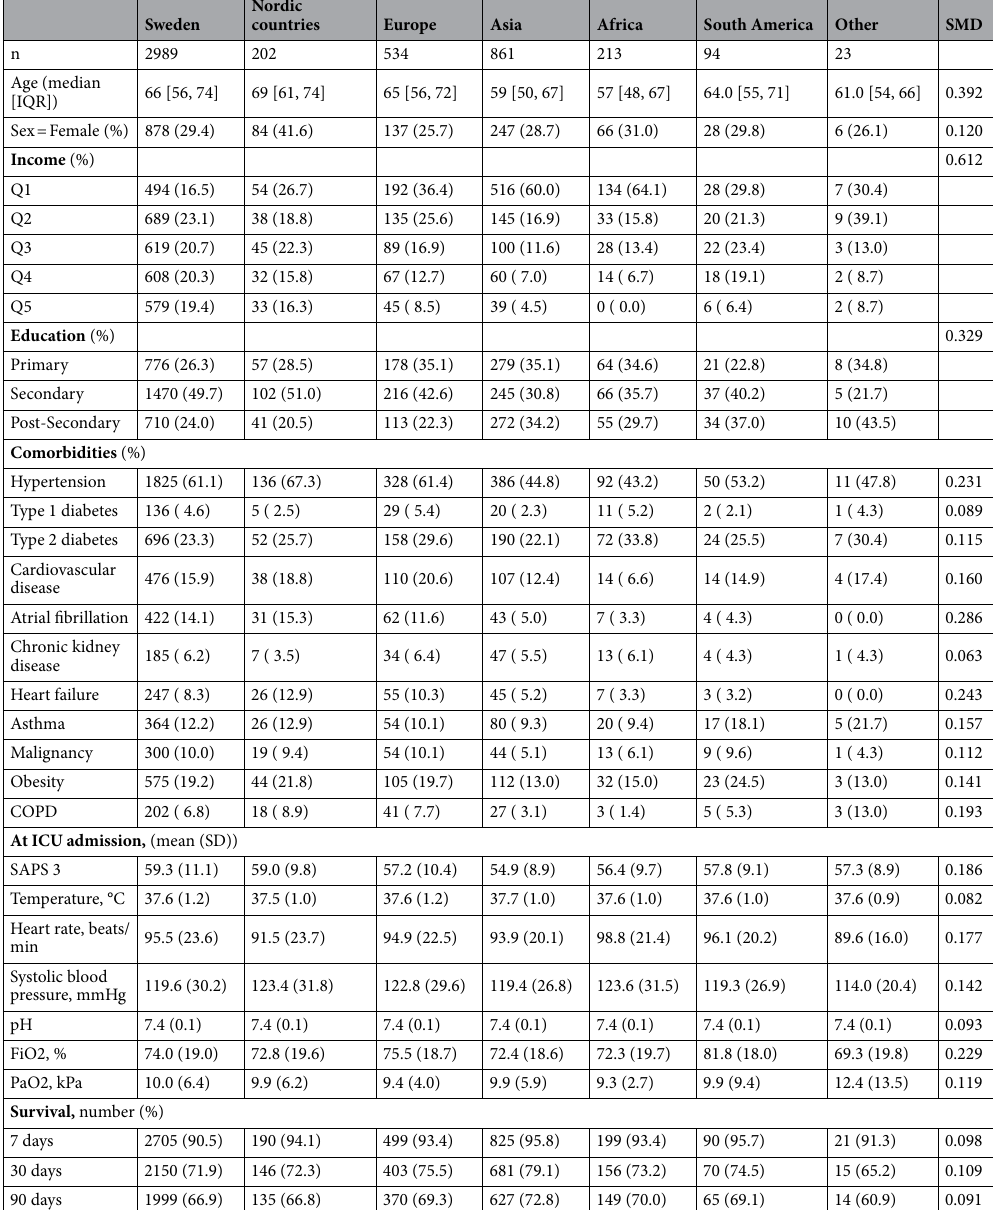
Table 2. Patient characteristics, intensive care measures and outcomes among patients admitted to ICU with severe Covid-19. Stratified by region of birth. SMD standard mean deviation; Q quintile; COPD chronic obstructive pulmonary disease; SAPS Simplified acute physiology